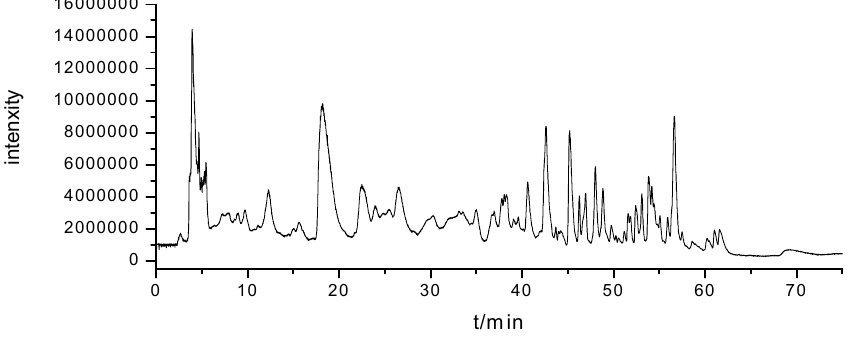
Figure 2. HILIC-ESI/TOF/MS chromatograms for Cordyceps